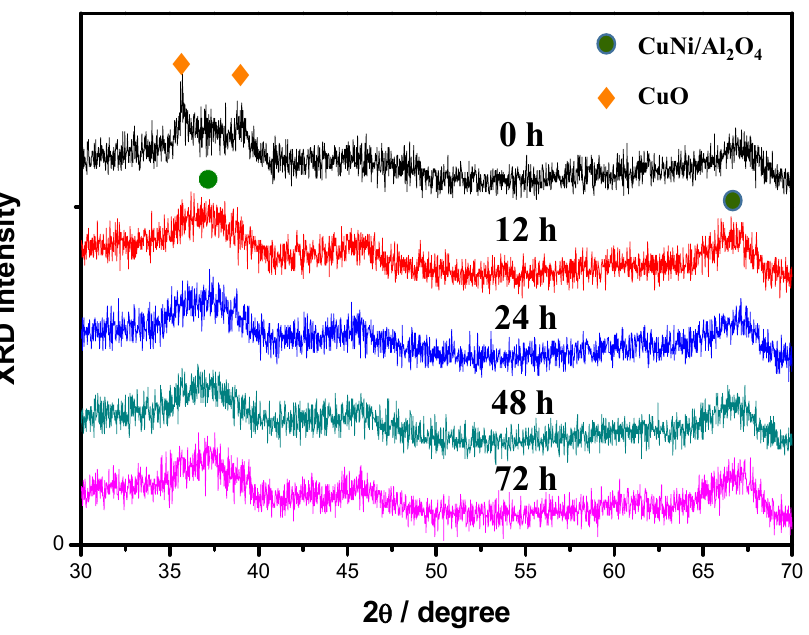
Figure 3. XRD patterns of the Cu-Ni/Al 2 O 4 samples hydrothermally treated for different times. (Note that all samples were obtained from a calcination at 600 °C).